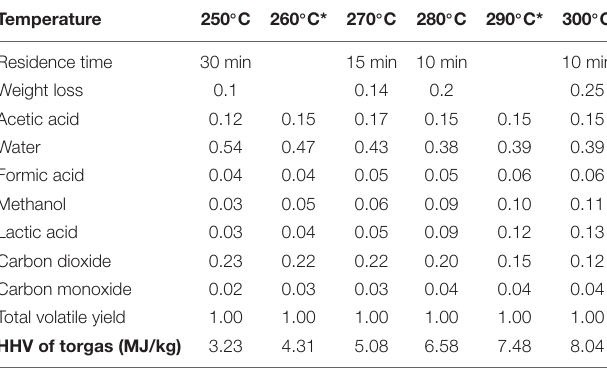
TABLE 3 | Torgas compositions and HHVs at different torrefaction conditions (Prins et al., 2006b) . Temperature